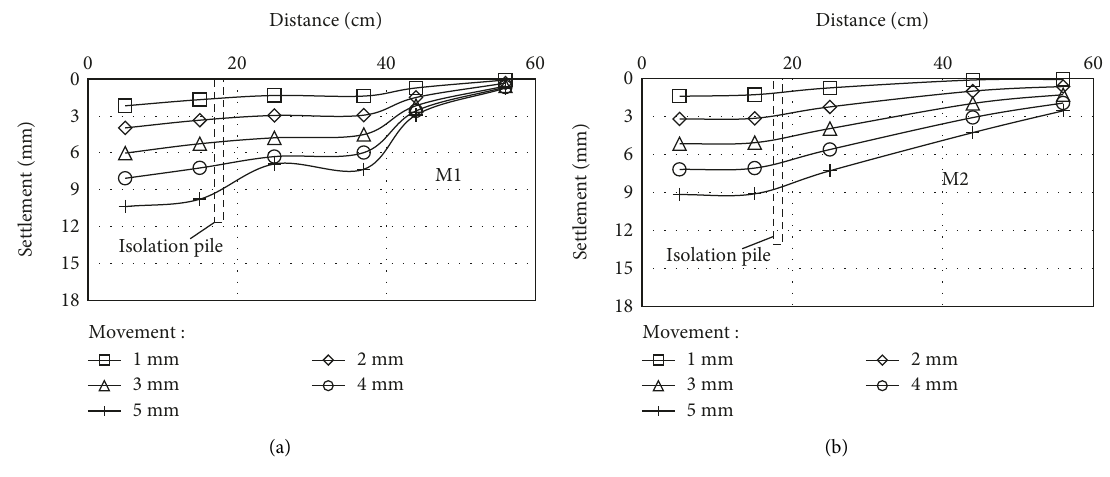
Figure 7: LVDTs measured settlement of the soil surface in samples (a) M1 and (b)